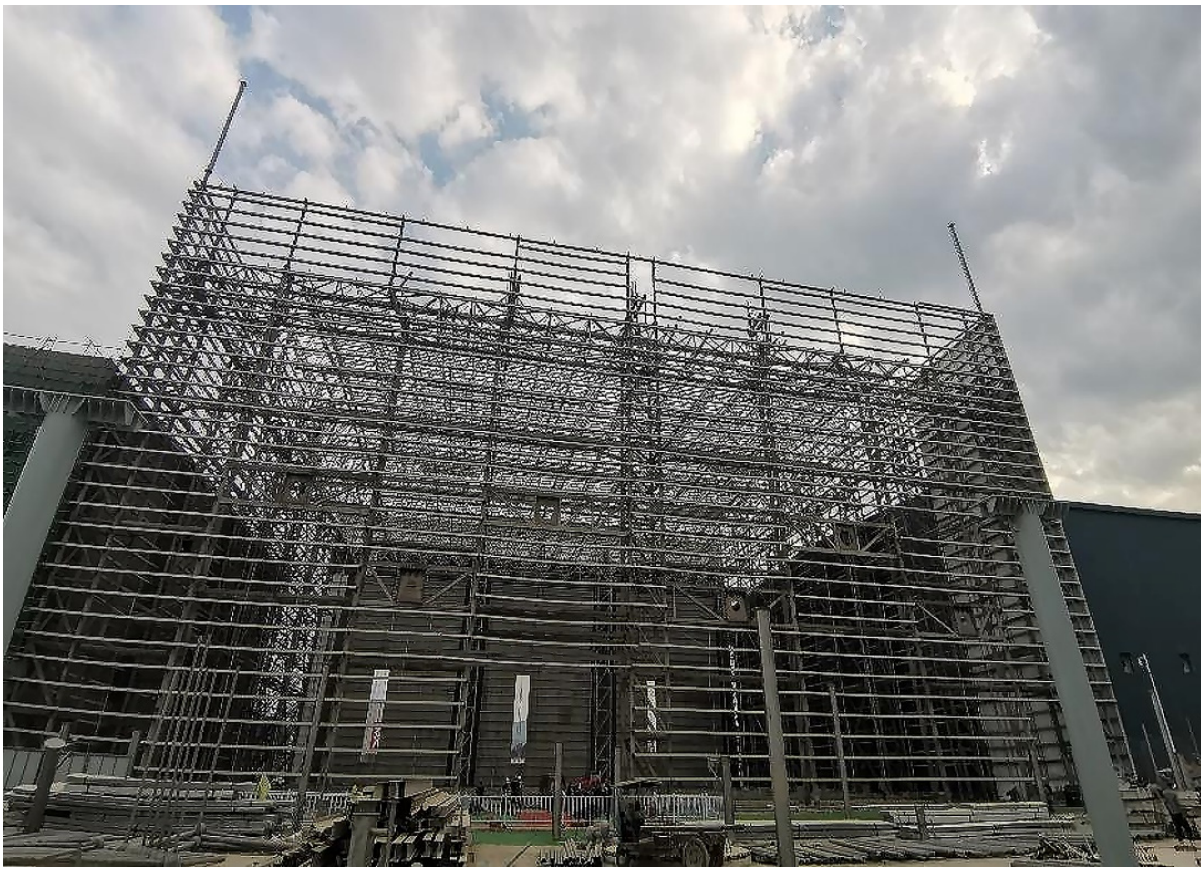
Figure 5. Converter station steel structure site.